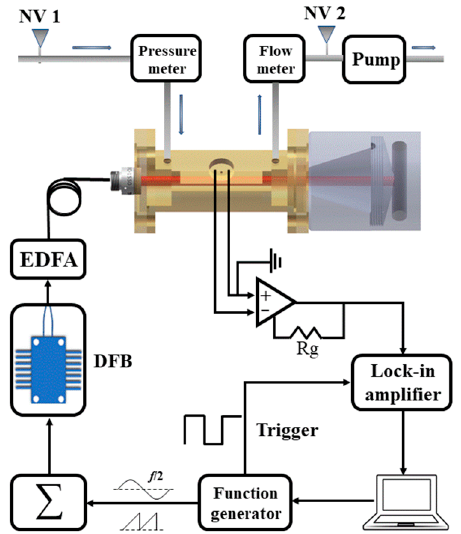
Figure 9. Schematic diagram of the H 2 S photoacoustic sensing system. EDFA: erbium-doped fiber amplifier; DFB: distributed feedback laser; NV: needle valve; Rg: preamplifier feed-back resistor.